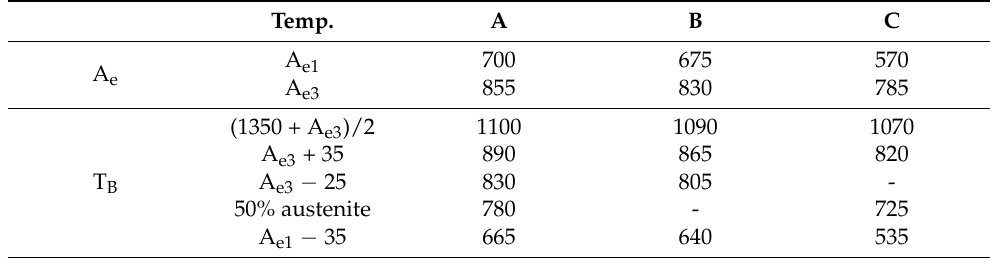
Table 2. Predicted critical temperature and the temperature T B ( ◦ C) applied in different trials.